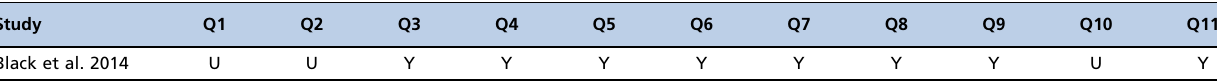
Table 3 - Critical appraisal results for included studies using the Joanna Briggs Institute for verification of cohort studies. Study